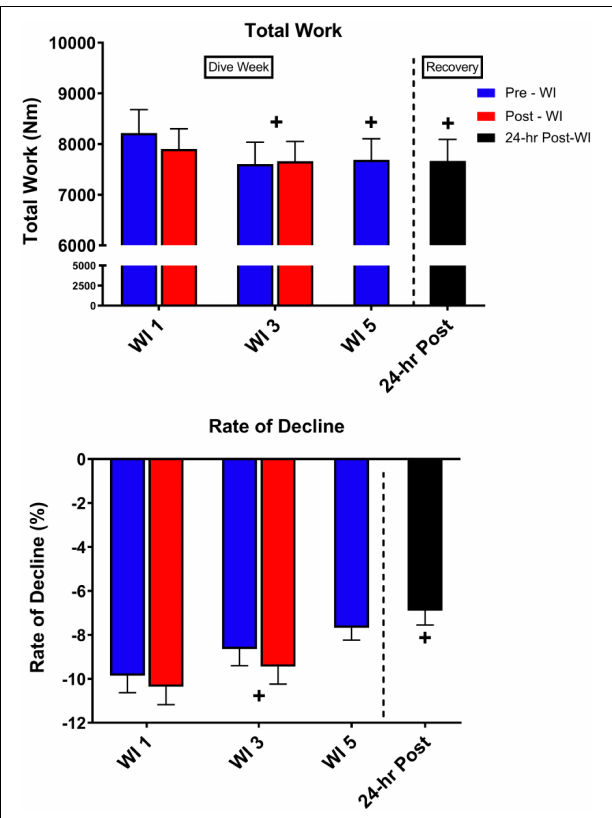
FIGURE 5 | Fifty-repetition maximal IK knee extension performance results. Across subject ( n = 13) mean ± SEM is shown. Total work was lowest on WI 3. However, the rate of fatigue was greatest on WI 1. “ + ” signifies day main effect ( p < 0.05).